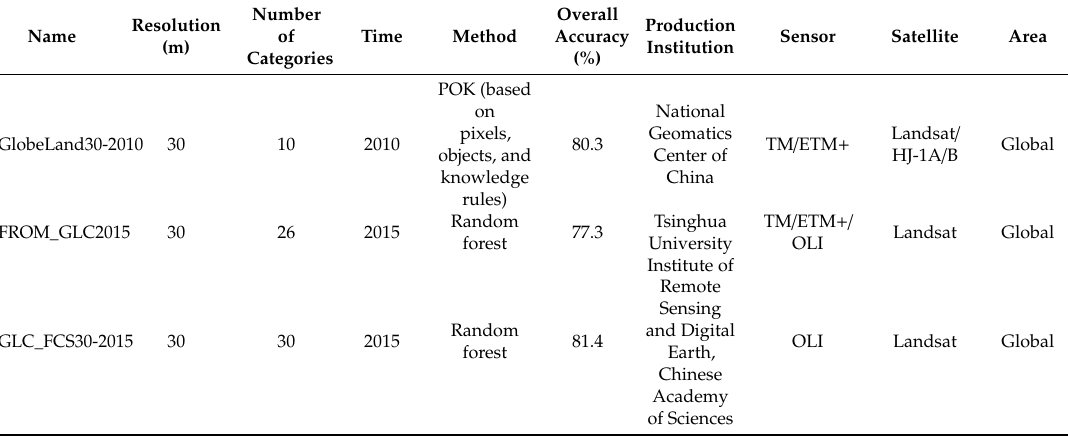
Table 1. Main parameters of di ff erent